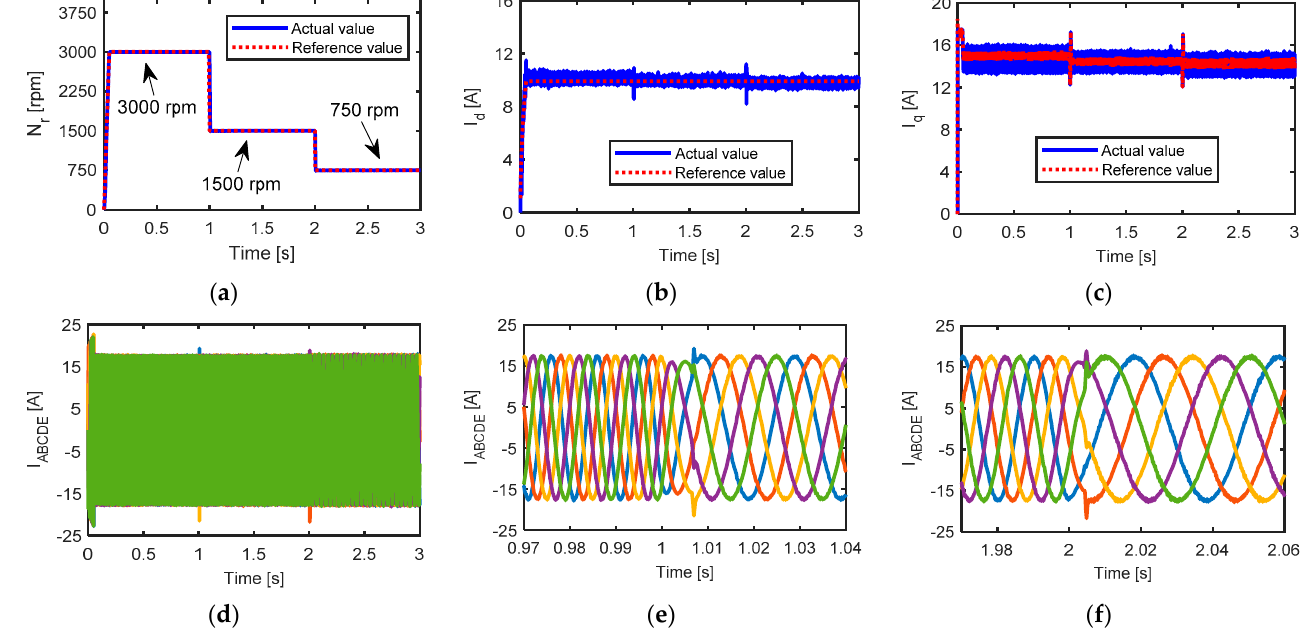
Figure 10. Simulated performance of the five-phase combined star-pentagon SynRM at rated torque and different speeds, ( a ) SynRM speed, ( b ) d-axis current, ( c ) q-axis current, ( d ) five-phase currents, and ( e , f ) zoom-in view of five-phase